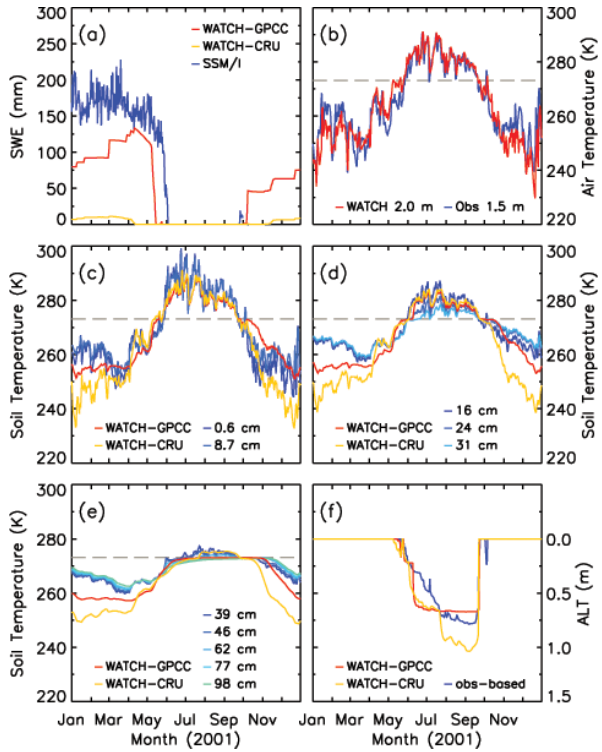
Fig. 7. Simulated snow mass, air and soil temperature and thaw depth at Toolik, Alaska in 2001 using two versions of the WATCH forcing data (based on GPCC and CRU precipitation) com- pared with observations: (a) snow water equivalent (SWE) derived from SSM/I satellite data (available from the ArcticRIMS project); (b) air temperature at 2.0m (WATCH forcing) and 1.5m (observed); (c) soil temperature in the top model layer (0–10cm), (d) second layer (10–35cm), and (e) third layer (35–100cm); (f) thaw depth or active layer thickness (ALT) calculated from the soil temperature profiles. Soil temperature observations are indicated by their depth of measurement.